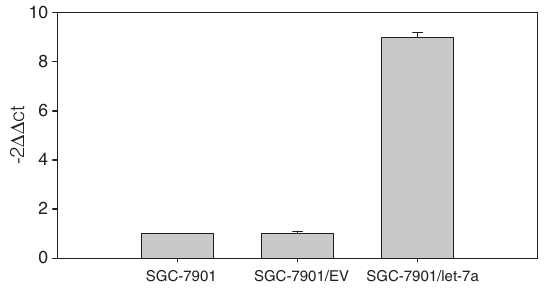
Fig. 3. Real-Time RT-PCR analysis of let-7a in SGC-7901, SGC- 7901/EV and SGC-7901/let-7a cells. The relative expression level of the let-7a was calculated by comparing the threshold cycle (Ct) values of samples to that of the reference (SGC-7901). For each sample tested, the three times of duplicate Ct values were averaged, Thecopiesoflet-7ainSGC-7901/let-7acellswere9-foldhigherthan in SGC-7901cells and SGC-7901/EV cells, respectively ( P =0.00). TherewasnosignificantincreaseinSGC-7901/EVcells,comparing to SGC-7901